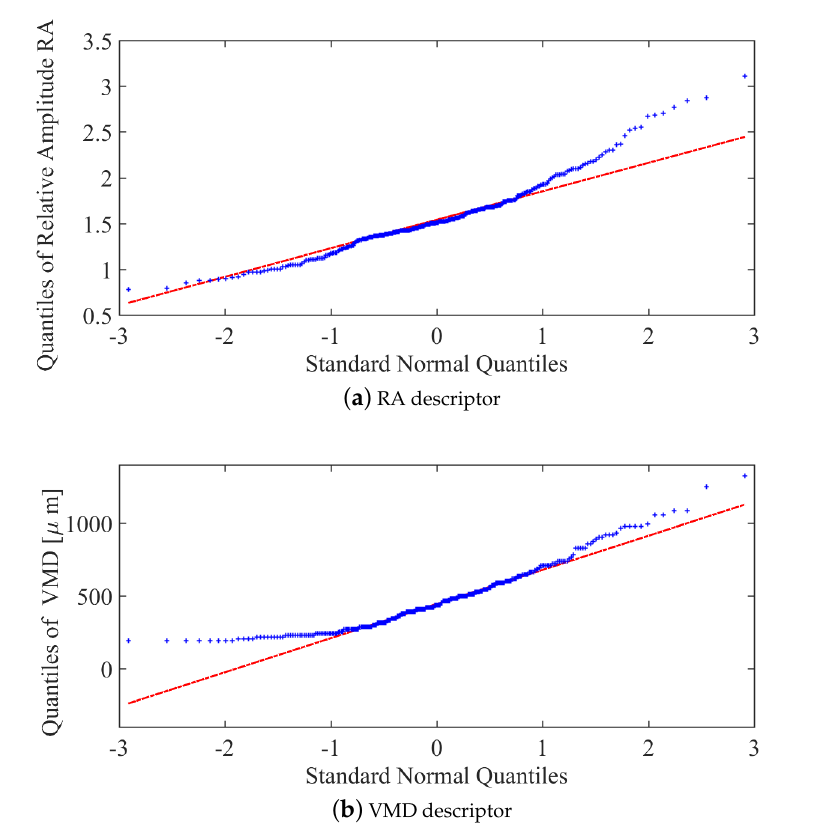
Figure 8. Quartile-quartile plot versus standard normal